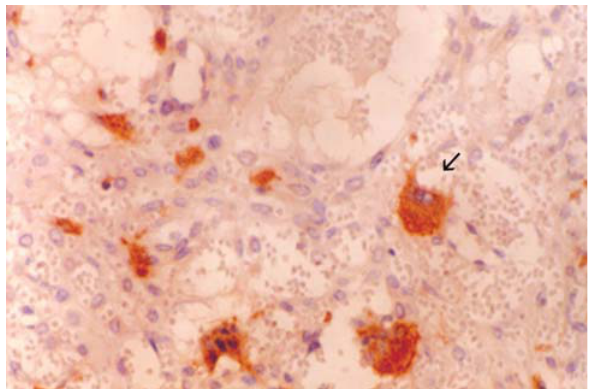
FIGURE 2 - Multinucleated giant cells and individual mononuclear cells CD68 positive in giant cell tumor of long bones (arrow) (SABC – 400x)